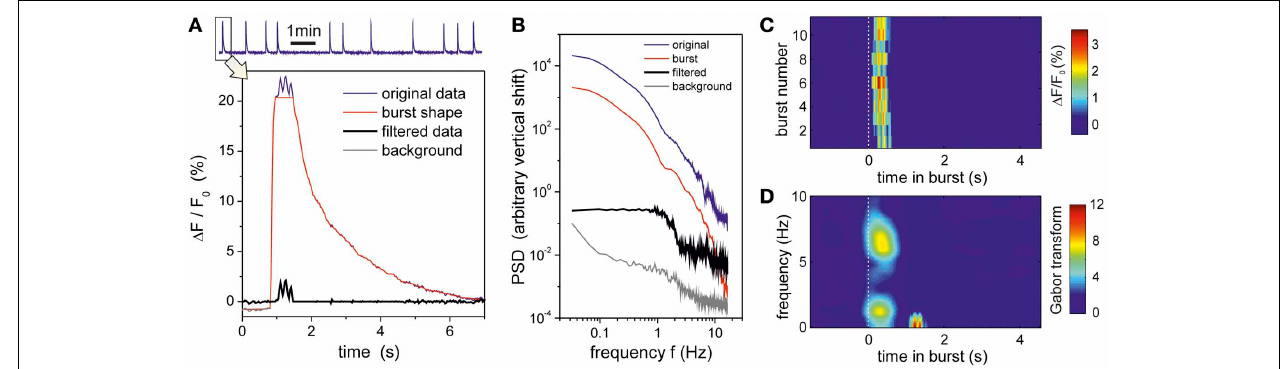
FIGURE 9 | Oscillations originate in the bursts. Data corresponds to the experiment at DIV 16 for [ CNQX ] = 200 nM. (A) The top trace depicts the average fluorescence time series of a group of 100 bursting neurons that constitute the Z 0 community. The first burst of this series and its manipulation is shown in detail in the bottom panel. The blue trace corresponds to the original fluorescence signal, and reveals a well pronounced oscillatory behavior at the peak of bursting. The original signal is separated into two contributions: the burst shape (red) and the oscillatory signal (black). Burst shape is estimated by applying a median filter with length L = 33 frames (1sec); the resulting trace follows the slow dynamics of the burst while the oscillatory signal keeps the higher frequency components. Activity out of the busting episodes (background signal, gray trace) is computed by connecting the periods in between bursting events. (B) The spectral analysis of the resulting signals reveals that the burst trace